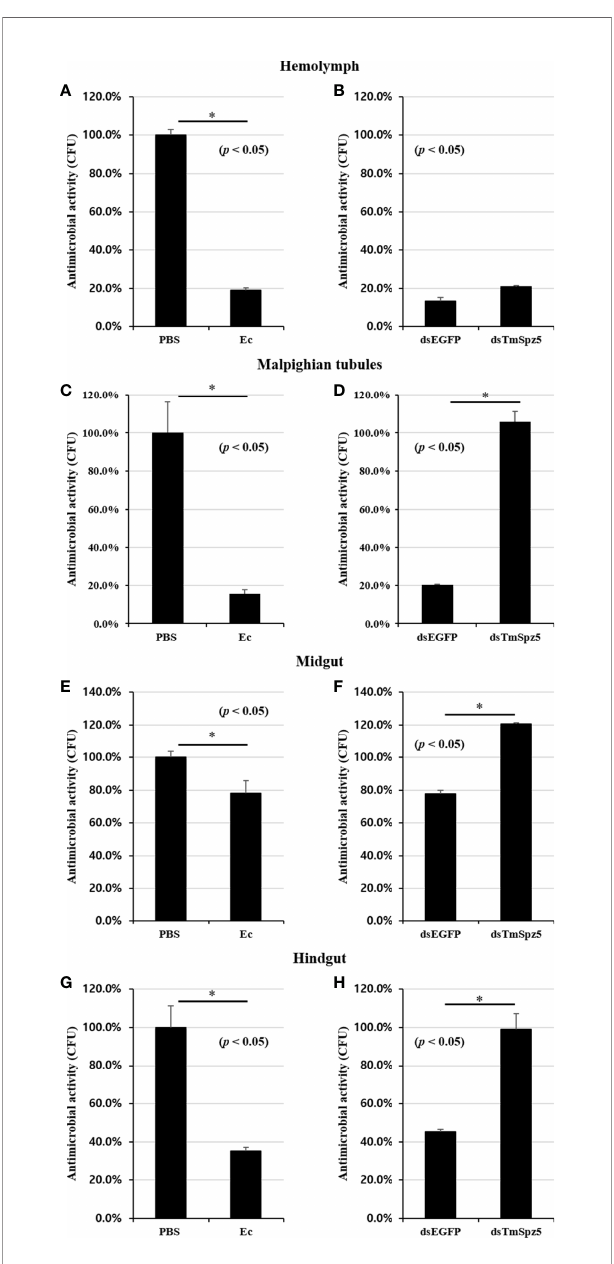
FIGURE 11 | Antimicrobial activity against E. coli in TmSpz5 -silenced larvae hemolymph, Malpighian tubules, midgut, and hindgut by CFU assay. (A, C, E, G) Antimicrobial activity evoked by E . coli (Ec) (10 6 cells/ m l) elicitation. PBS- injected T. molitor was used as a negative control (Cont). E . coli -injected T. molitor hemolymph and Malpighian tubules had higher antimicrobial activity compared with control group (A, C) . (B, D, F, H) E . coli (10 6 cells/ m l) was injected into ds TmSpz5 -treated T. molitor larvae. ds EGFP -treated larvae were used as a negative control. The result shows that the antimicrobial activity was decreased by treatment of ds Spz5 compared with the ds EGFP -treated group majorly in Malpighian tubules (D) , hindgut (H) , and midgut (F) in a depleting manner. E. coli proliferation remained indifferent in the ds TmSpz5 - treated group compared with ds EGFP -treated larvae in hemolymph (B) . Asterisks indicate signi fi cant differences between ds TmSpz5- and dsEGFP- injected